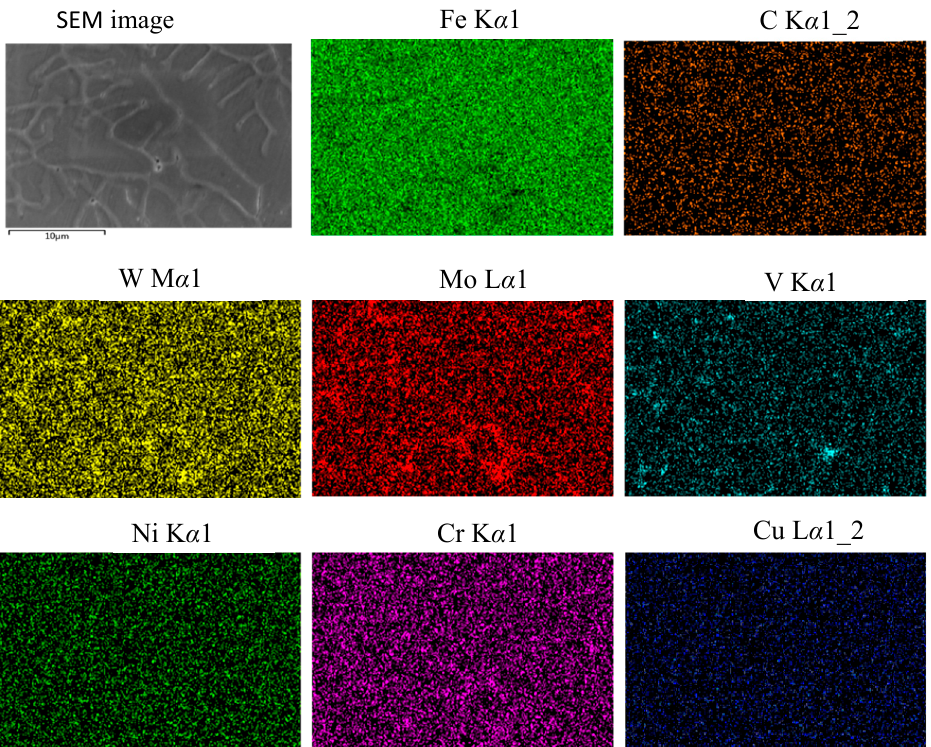
Figure 6. The morphology of dendritic grain and its element distribution.